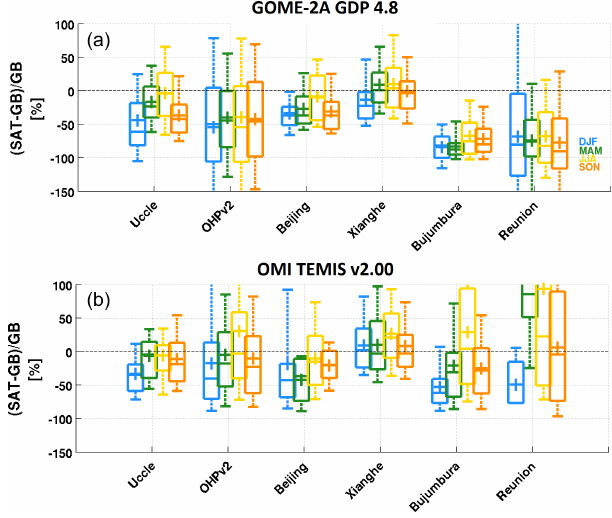
Figure 13. Bias (in percent) between daily tropospheric NO 2 columns from satellites, ( a ) GOME-2A and ( b ) OMI, and a selec- tion of BIRA-IASB MAX-DOAS stations, for the different seasons. A dilution correction is applied to the satellite data when relevant. The box-and-whisker plots are defined as in Fig.